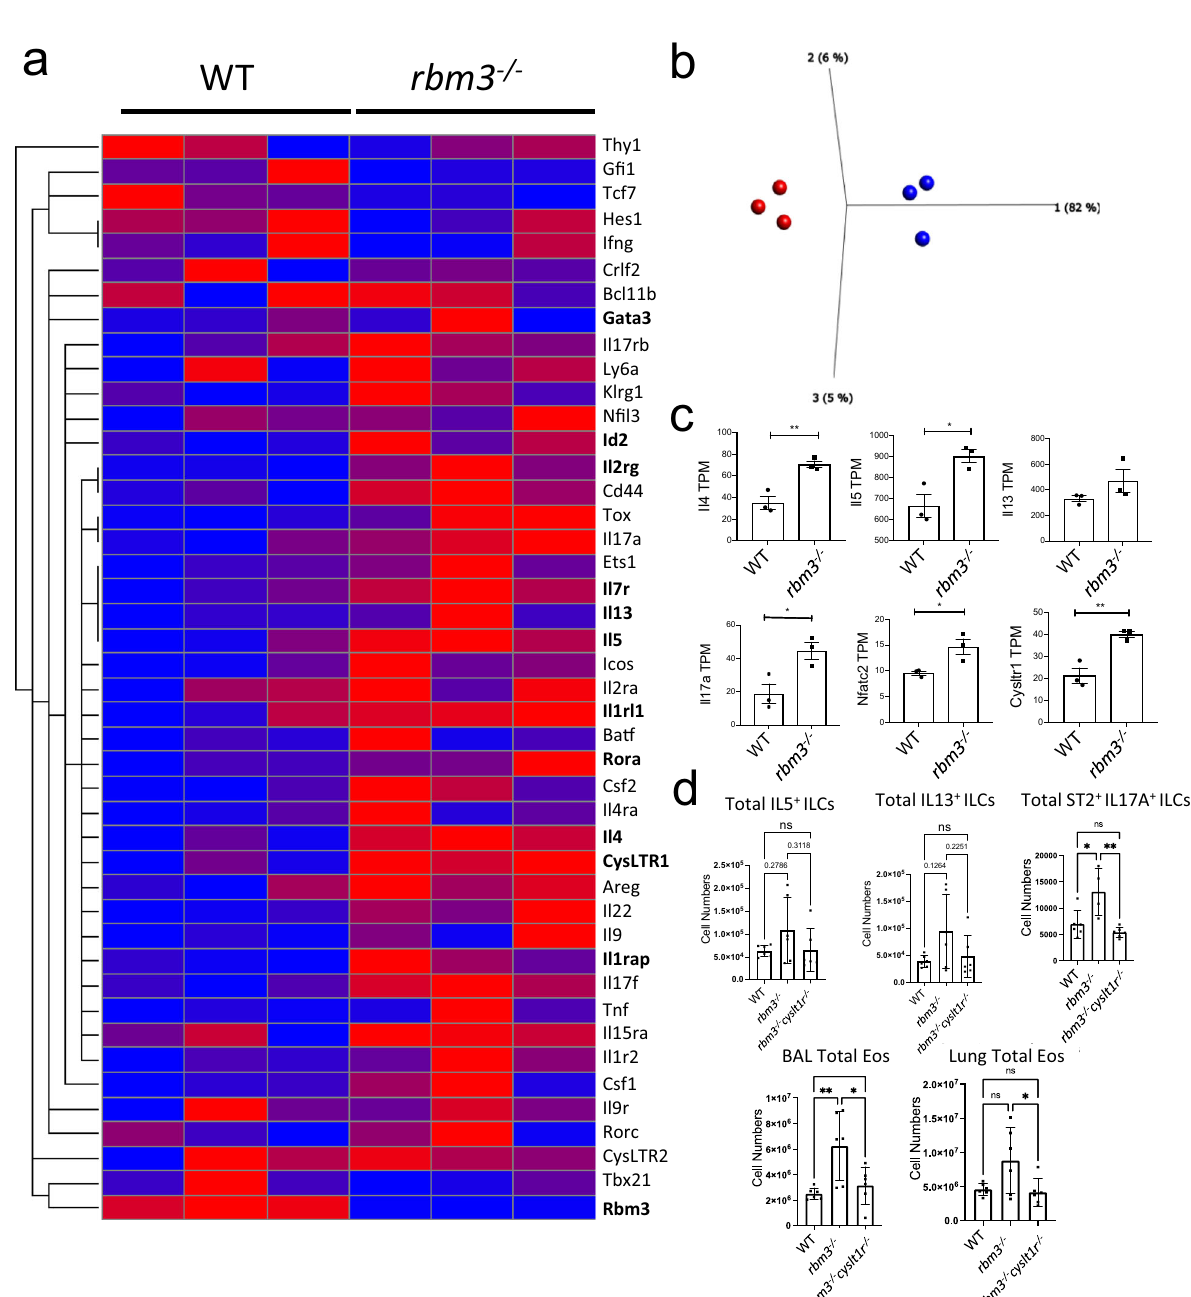
Fig. 7 | CysLT1R controls eosinophilia and ST2 + IL-17 + ILC2 accumulation in Rbm3 − / − mice. WT and Rbm3-/- mice were challenged with 25 µ g Alternaria